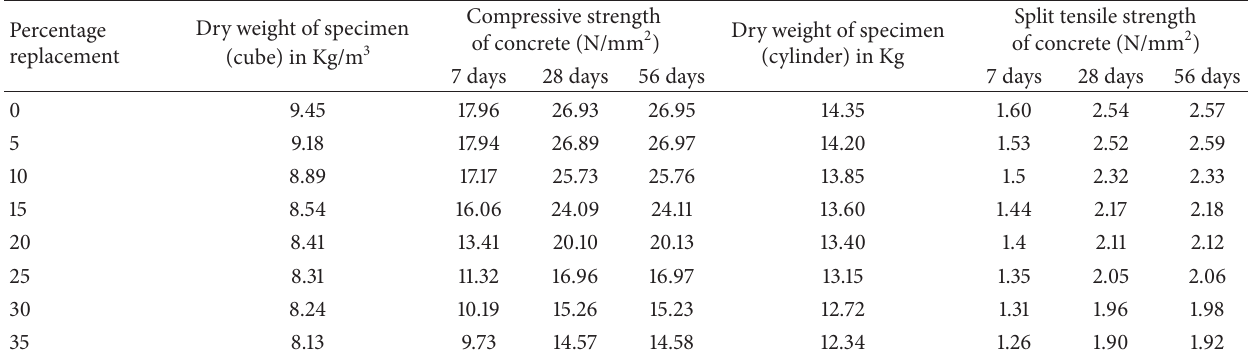
Table 1: Mechanical properties of